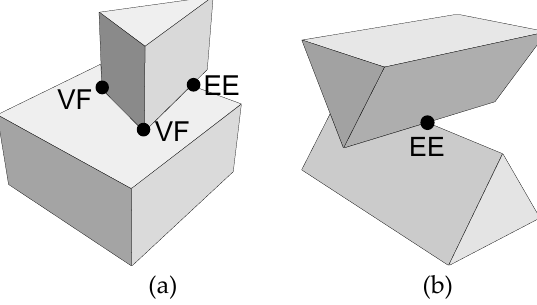
Figure 1. Representation of block interactions by elementary point contacts of vertex-to-face type (VF) and edge-to-edge type (EE): ( a ) Face-to-face block contact; ( b ) Edge-to-edge block contact.